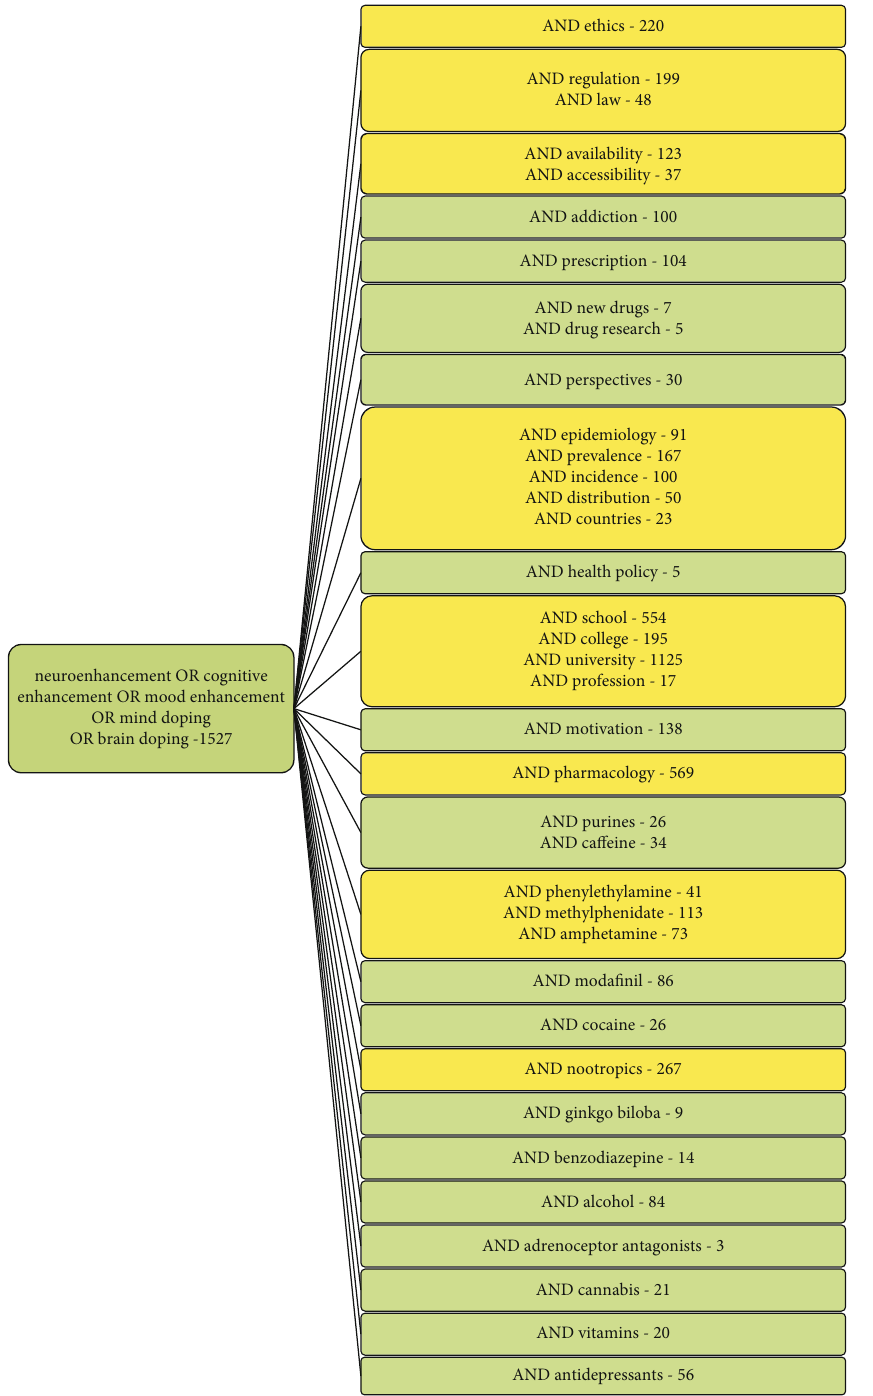
Figure 2: Number of publications in pNE and related sub fi elds. Results of a PubMed literature search using relevant keywords for pNE and pNE subtopics. Publications till 11/2020 are considered in this query. Based on the number of articles, some aspects, such as epidemiology, accessibility and diversion strategies, pharmacology, and ethics, seem to attract speci fi c scienti fi c attention (highlighted in